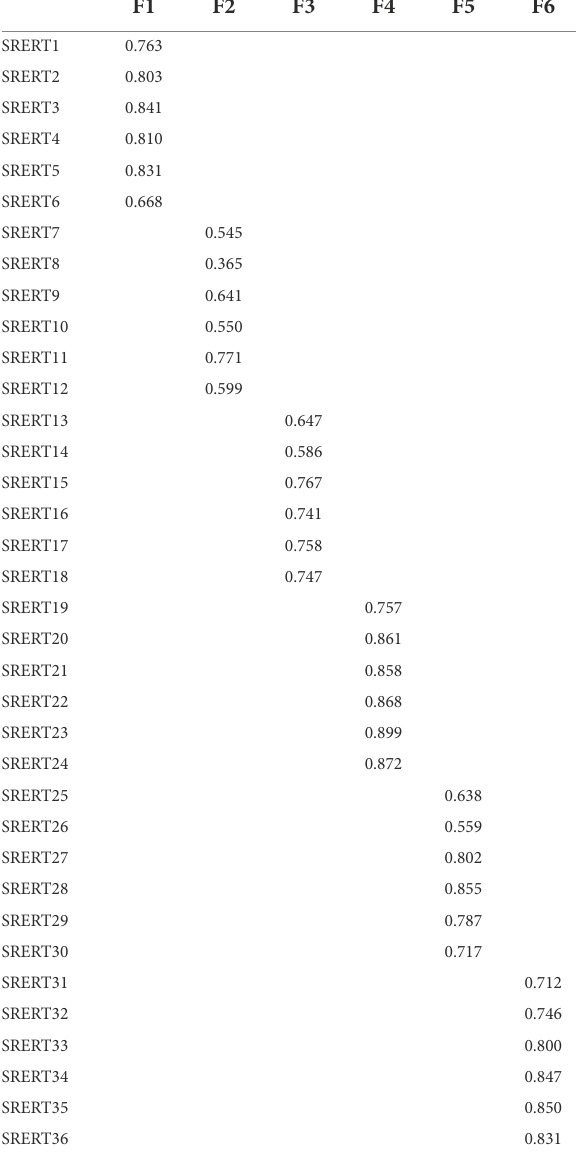
TABLE 22 Standardized total effects (default model; n =